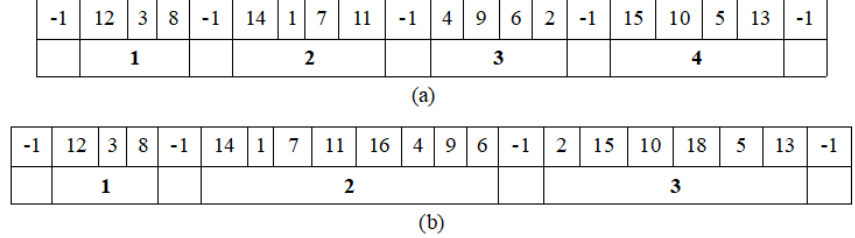
Figure 1. Example of the proposed representation. ( a ) is a feasible solution without accessing power stations. ( b ) is a feasible solution accessing power